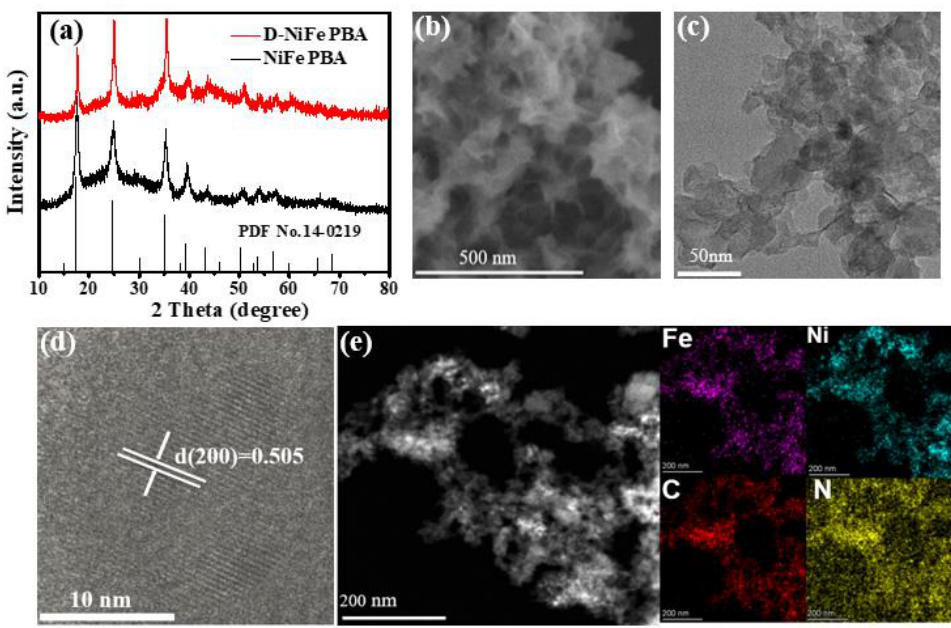
Figure 2. ( a ) PXRD spectra of NiFe PBA and D-NiFe PBA. ( b ) SEM images of D-NiFe PBA. ( c ) TEM images of D-NiFe PBA. ( d ) HRTEM images of D-NiFe PBA. ( e ) EDX element mapping for D-NiFe PBA.